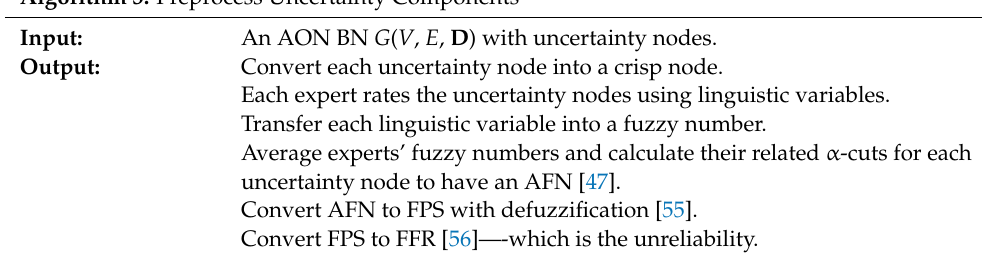
Algorithm 3: Preprocess Uncertainty Components